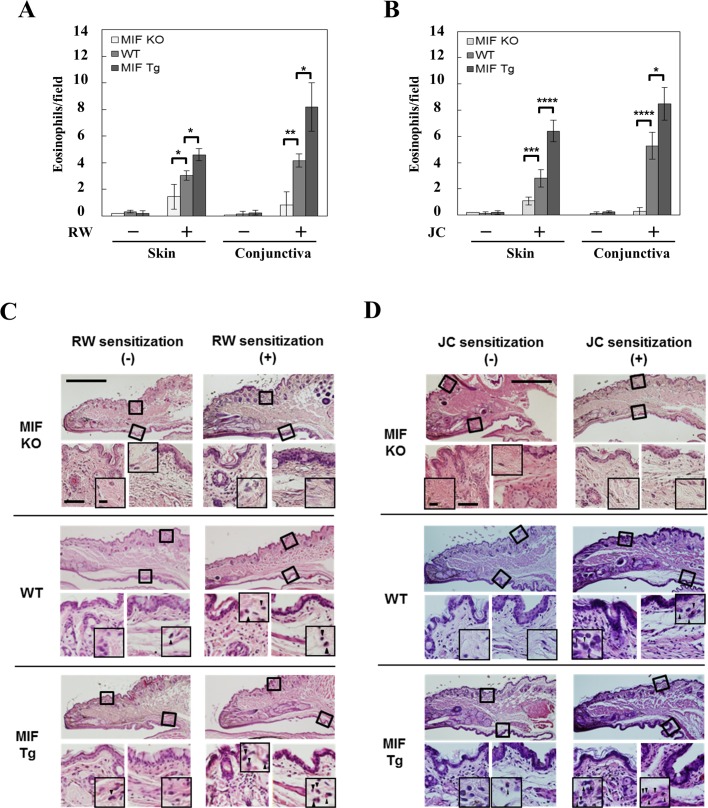
The eosinophil infiltration of experimental pollen-induced conjunctivitis and dermatitis following active immunization.The number of eosinophils in (A) RW and (B) JC pollen-sensitized conjunctiva and eyelid skin sites of MIF KO and MIF Tg mice were compared with those in WT mice. Each value represents the mean ± SD (n = 5 in each group, *P<0.05, **P<0.005, ***P<0.0005, ****P<0.0001). The Student's t-test was used. (C and D) The histological features of RW (C) and JC (D) pollen-sensitized conjunctiva and eyelid skin sites of MIF KO, MIF Tg and WT mice. HE-stained section of the palpebral part (upper panel), eyelid skin (lower left panel) and conjunctiva (lower right panel) are shown. The arrowheads point to eosinophils. The scale bars indicate 500 μm (upper panel), 50 μm (lower large panel) and 10 μm (lower small panel).